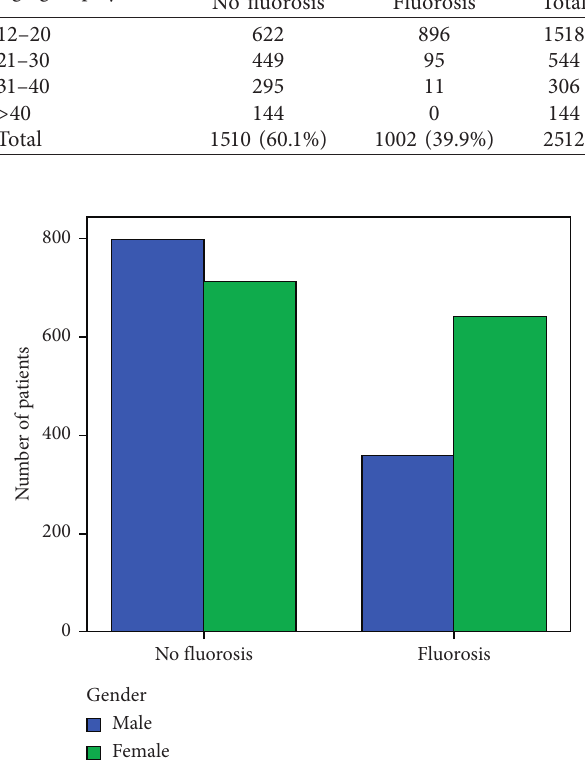
Figure 1: Incidence of fluorosis grouped by gender. Table 2: Location of incidence of